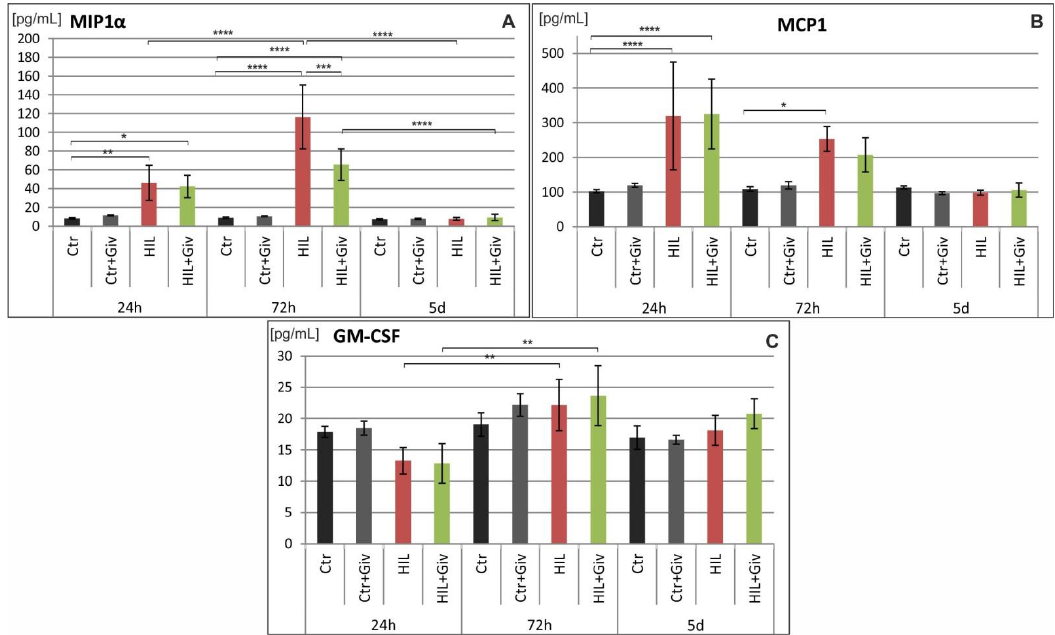
Figure 11. Chemokine profile in neonatal rat brains after hypoxia-ischemia. Quantitation of MIP α 1 ( A ), MCP1 ( B ) and GM-CSF ( C ) protein levels detected in the rat brain of control animals and 24 h, 72 h and 5 days after hypoxia-ischemia, treated and untreated with Givinostat. Note the increased levels of MIP- 1α and MCP1 24 and 72 h after HI. Givinostat significantly decreased the level of MIP- 1α at 72 h after insult. The values are the mean ± SD from five animals per group and time point. One-way ANOVA indicated significant differences between the investigated experimental groups: * p < 0.05; ** p < 0.01; *** p < 0.001; **** p < 0.0001.